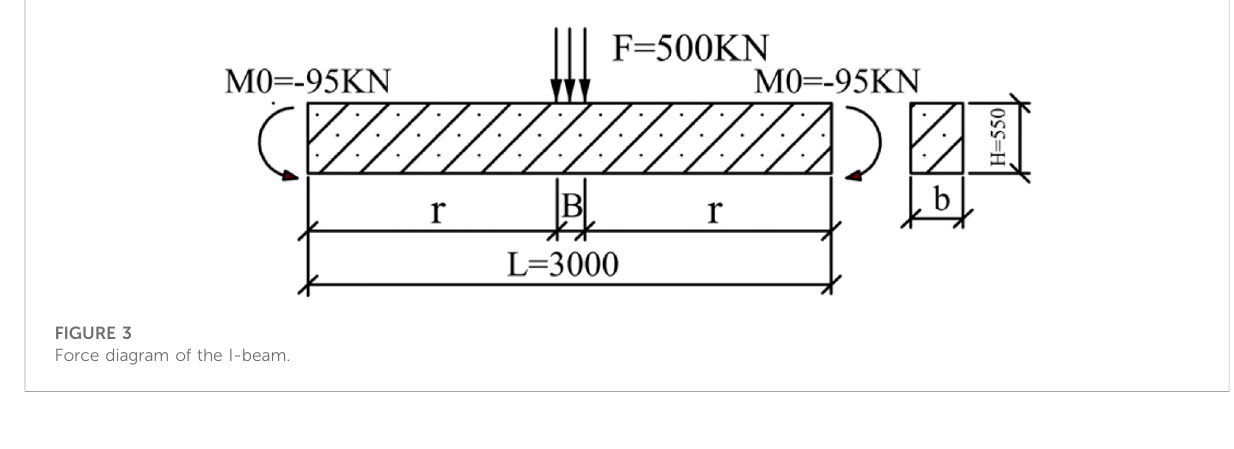
FIGURE 3 Force diagram of the I-beam.